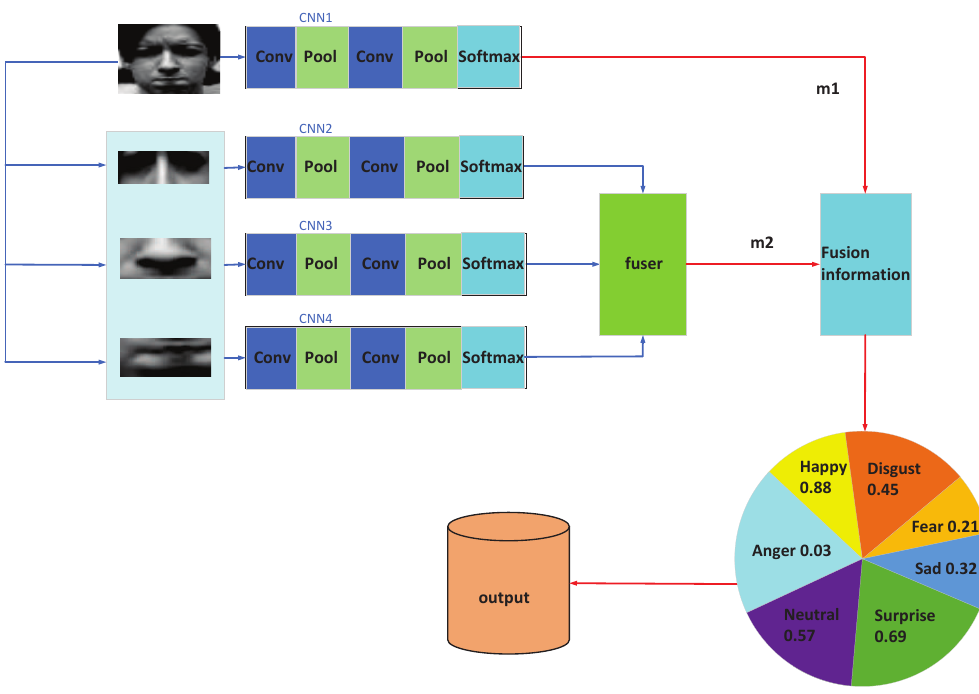
Figure 8. The structure of facial expression recognition system based on auxiliary model.